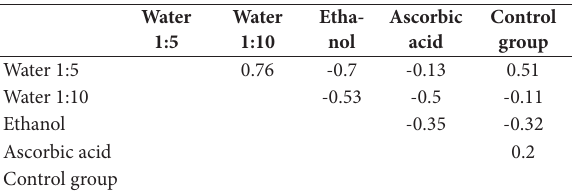
Table 3. Pairwise Pearson correlation of thiobarbituric acid re- active substances (TBARS) in samples T. pratense extracts, n = 6.